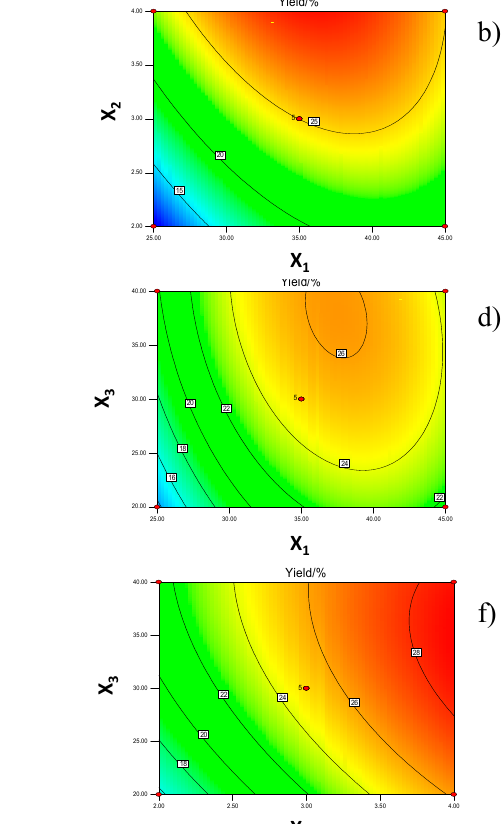
Table 2. Analysis of variance (ANOVA) for the regression model.